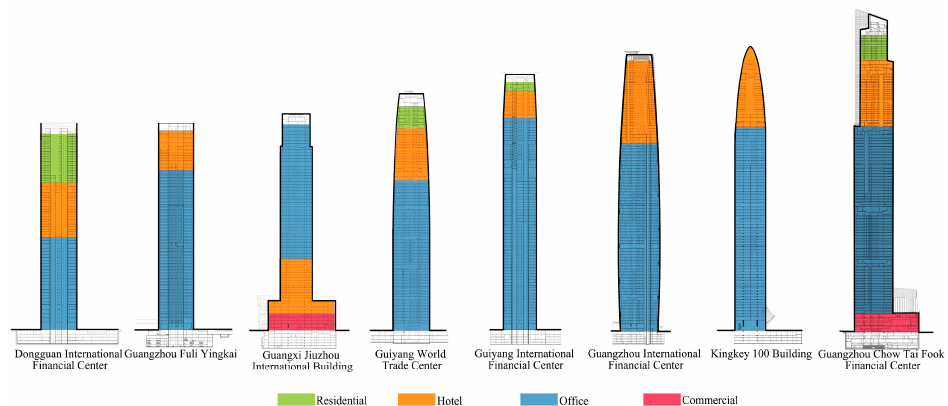
Figure 10. Building shapes and vertical distribution of business types.